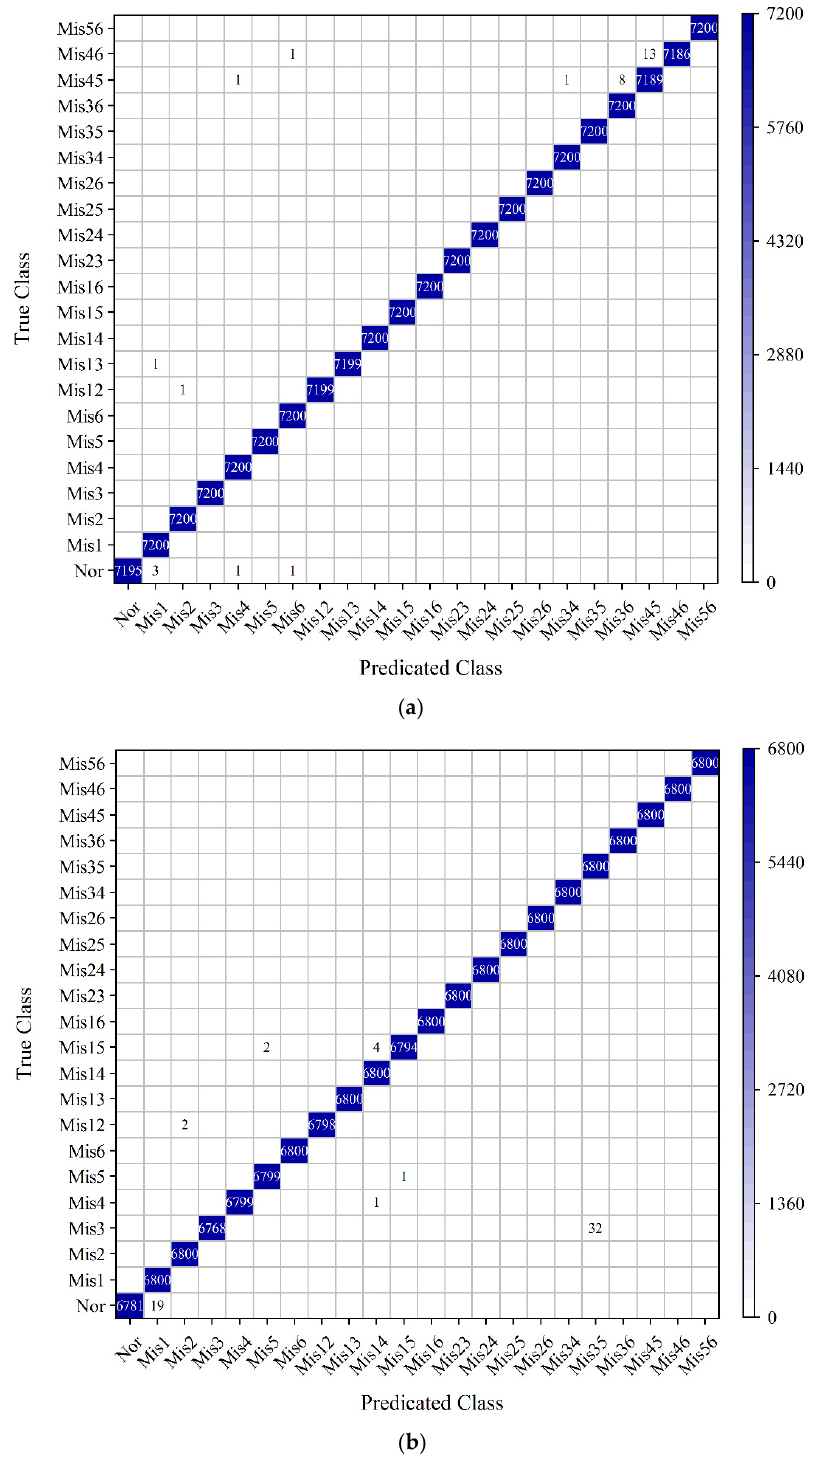
Figure 20. Confusion matrices of the results acquired with the third network and data division mode 2_c. ( a ) Training result. Total accuracy is 99.98%. ( b ) Testing result. Total accuracy is 99.96%. Table 5. The best accuracies for different networks under different data division